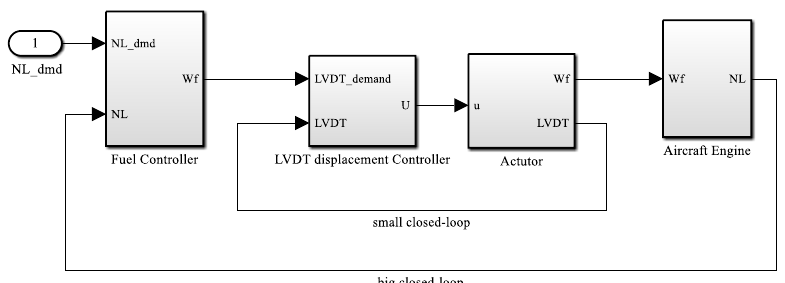
Figure 9. Speed closed-loop control model in Simulink.